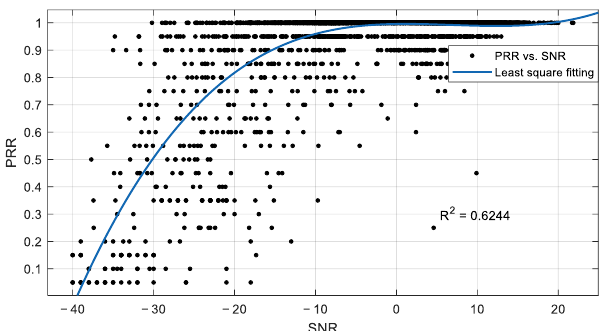
Figure 1. Fitting diagram of the SNR and PRR.